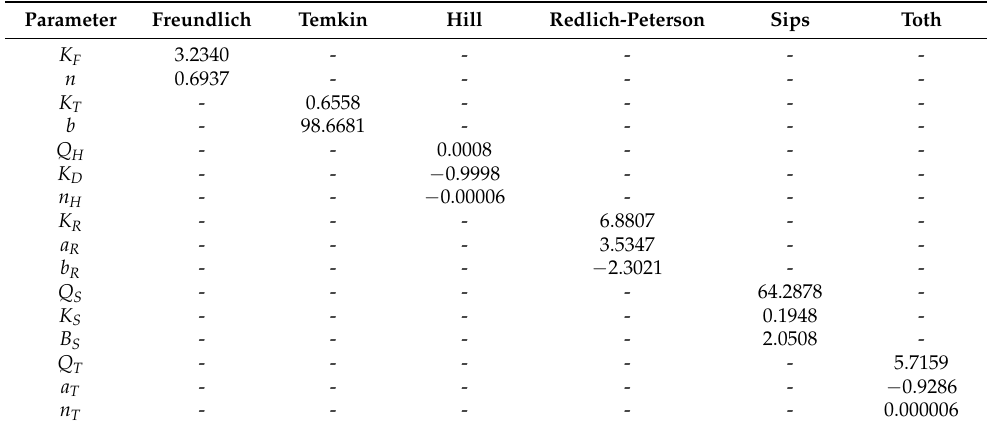
Table 9. Equilibrium isotherm parameters of the biosorption process conducted on SPRBA 5%